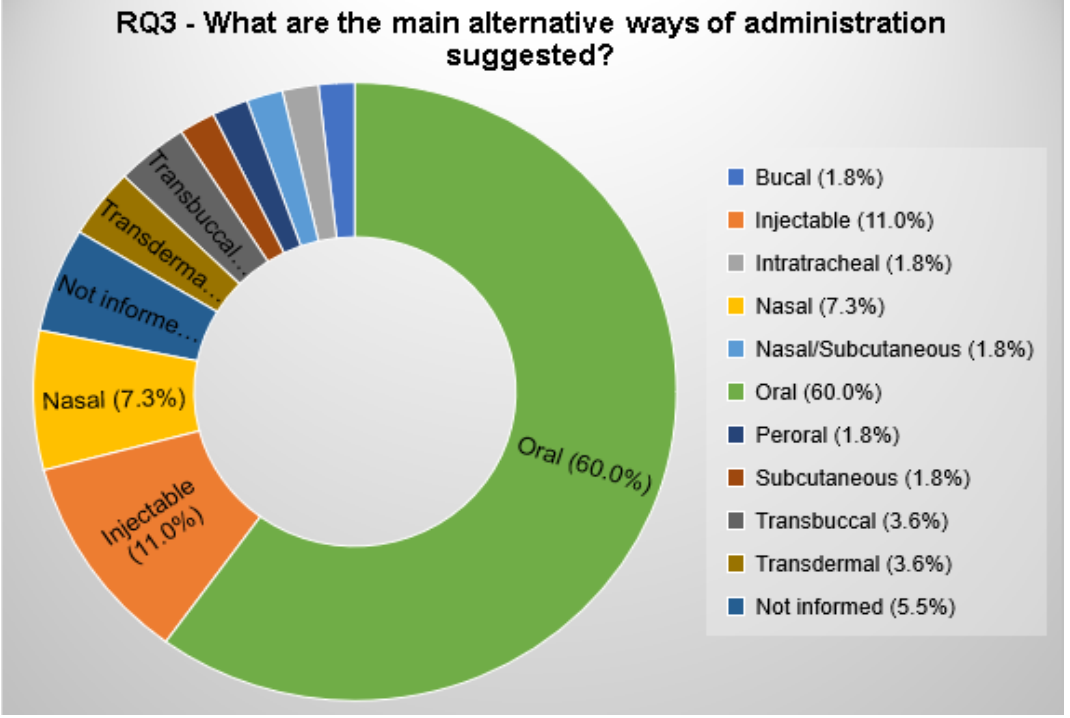
Figure 10. Alternative ways of administration suggested by the selected articles.